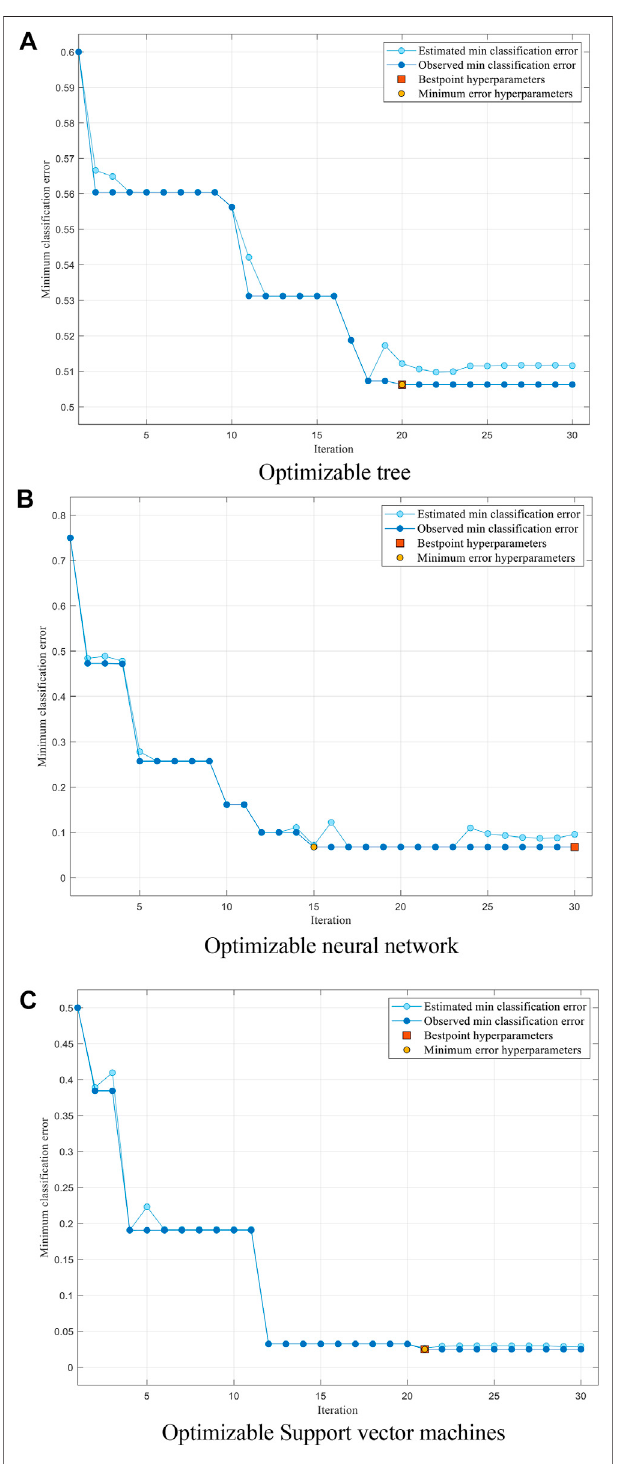
FIGURE7| Parameteroptimizationprocessgraph. (A) Optimizabletree, (B) Optimizableneuralnetworkand (C) OptimizableSupportvectormachines.